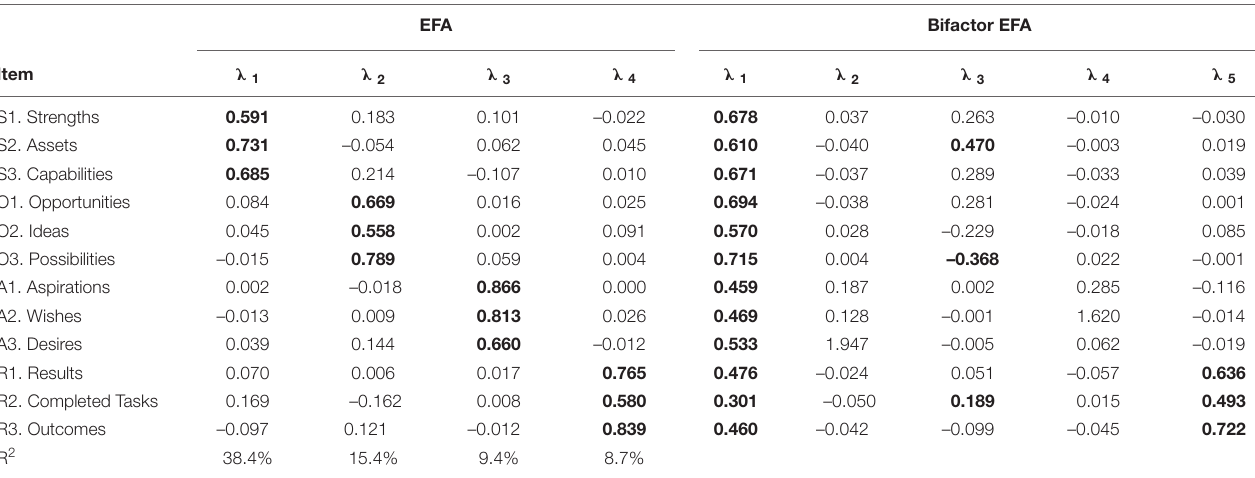
TABLE 1 | Exploratory factor analysis and bifactor EFA of the SOAR